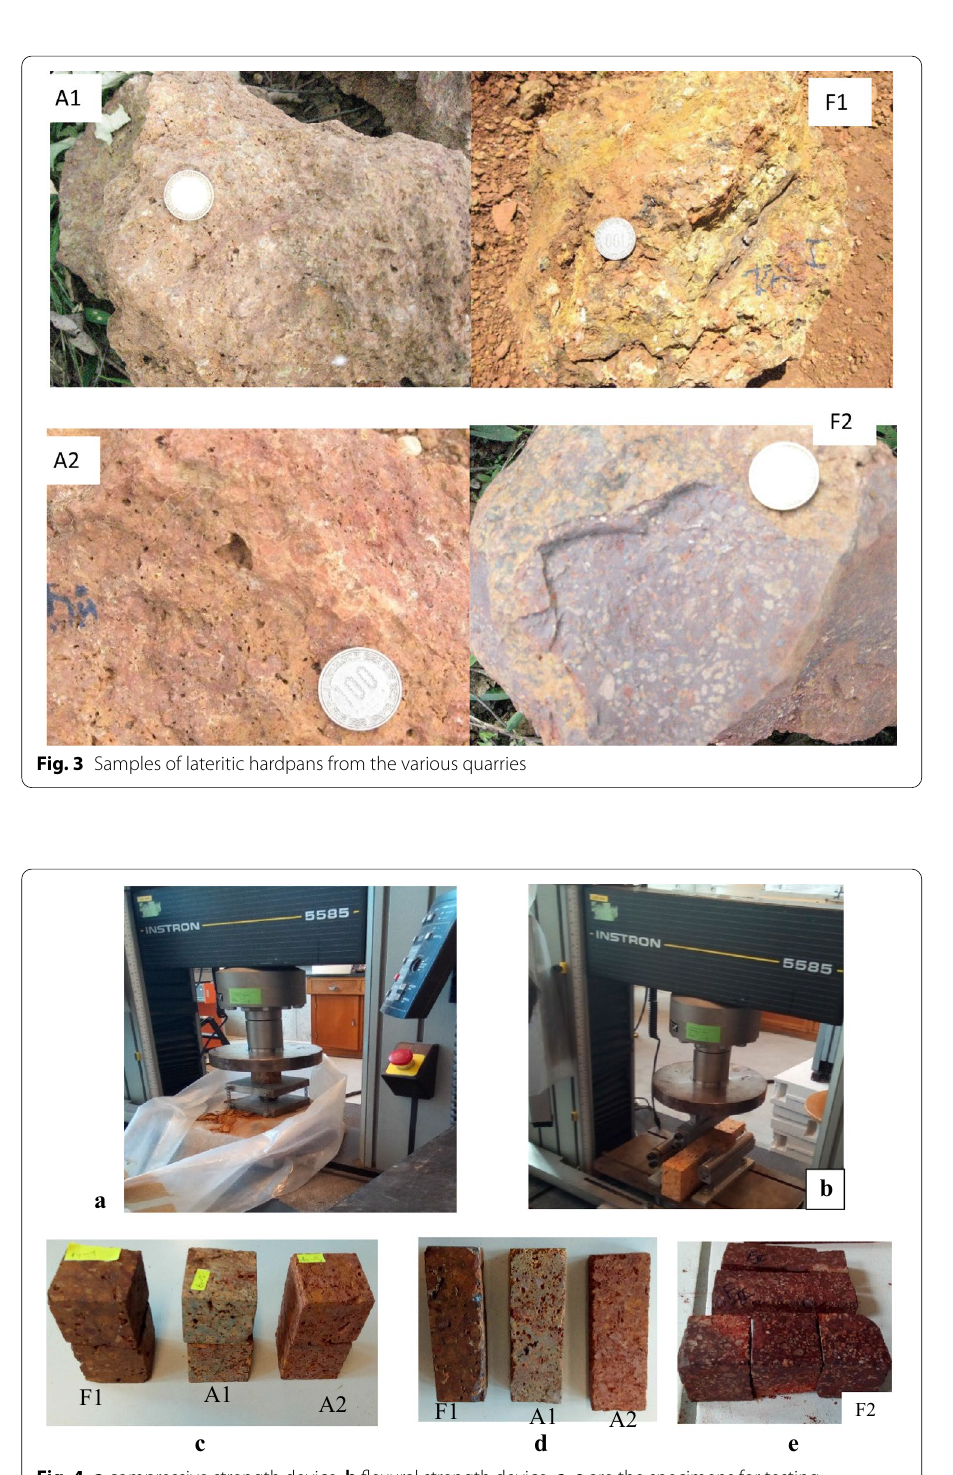
Fig. 4 a compressive strength device, b flexural strength device, c – e are the specimens for